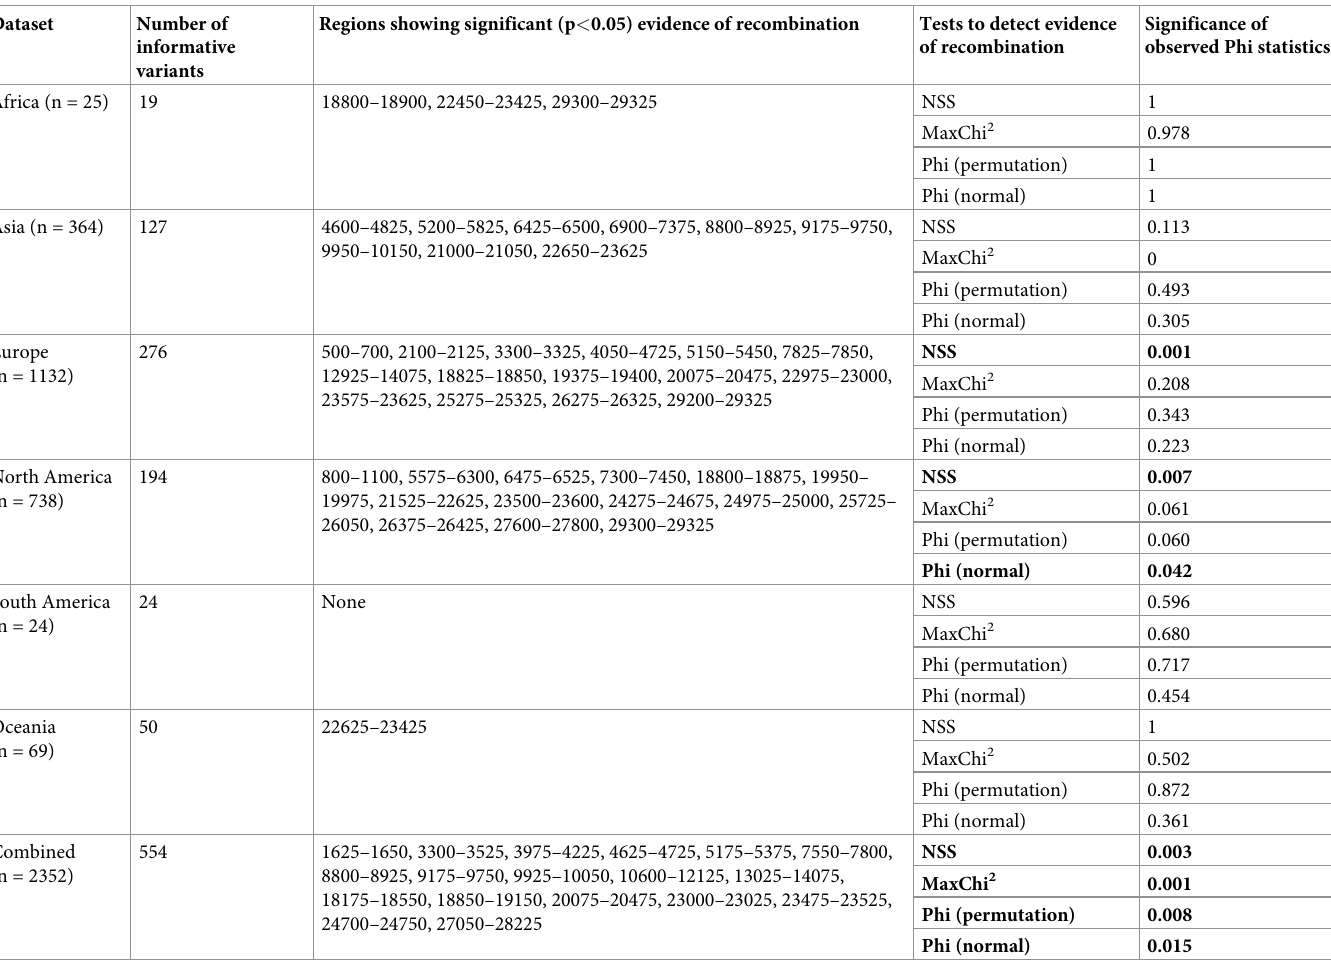
Table 1. Evidence of recombination in the sequences from continental datasets and regions exhibiting evidence of recombination observed from ‘Profile’ program in continental